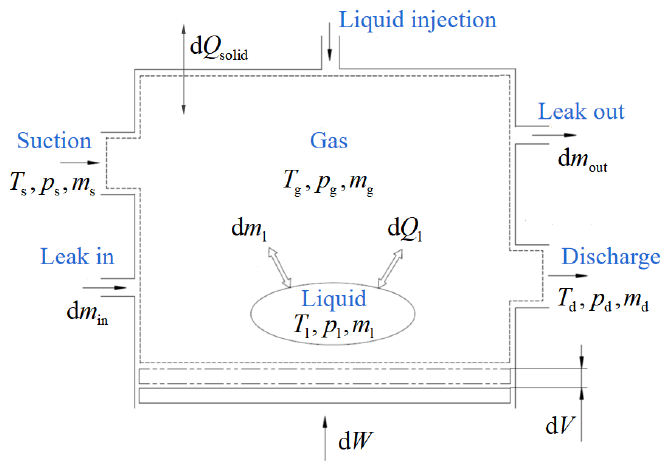
Figure 4. Schematic diagram of the lump model of screw